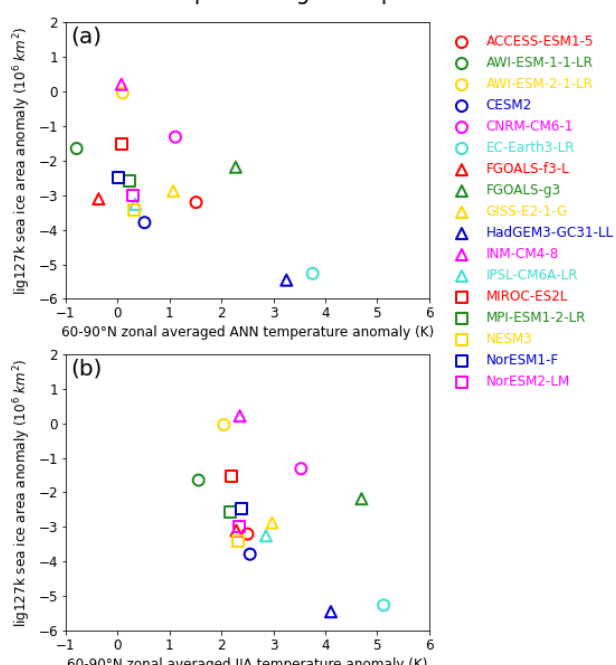
Figure 7. (a) lig127k August–September sea ice NH area anomaly (10 6 km 2 ) versus lig127k annual 60–90 ◦ N surface air tempera- ture anomaly ( ◦ C); (b) lig127k August–September NH sea ice area anomaly (10 6 km 2 ) versus lig127k JJA 60–90 ◦ N surface air tem- perature anomaly ( ◦